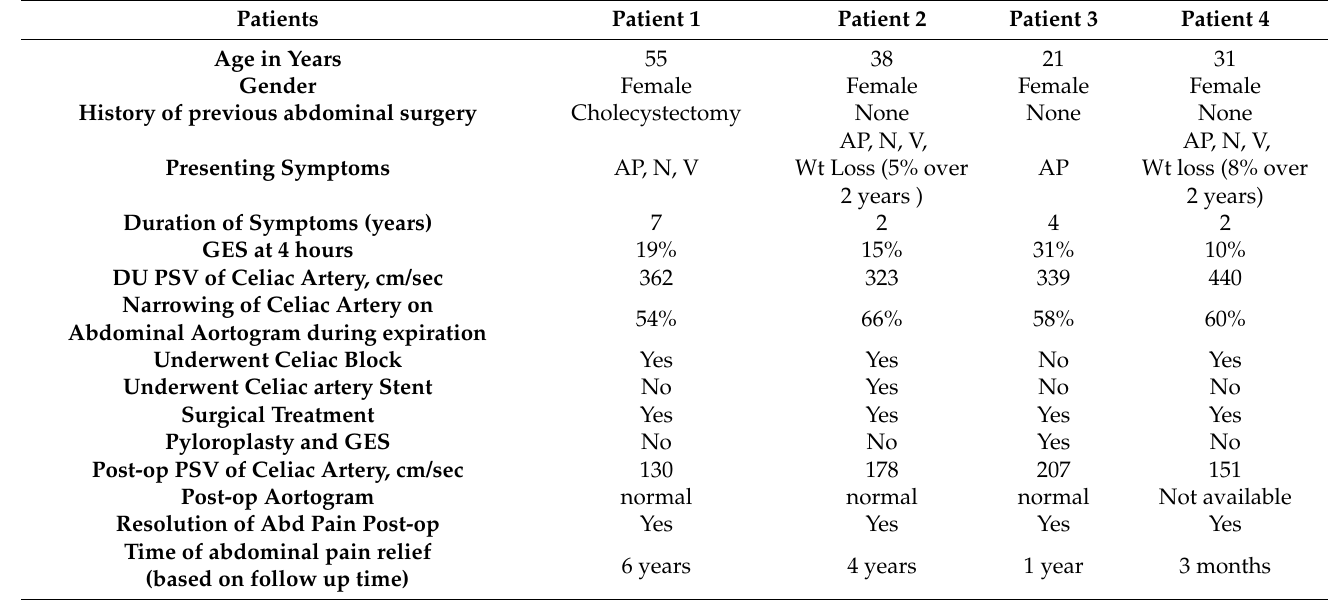
Table 2. Clinical presentation of the